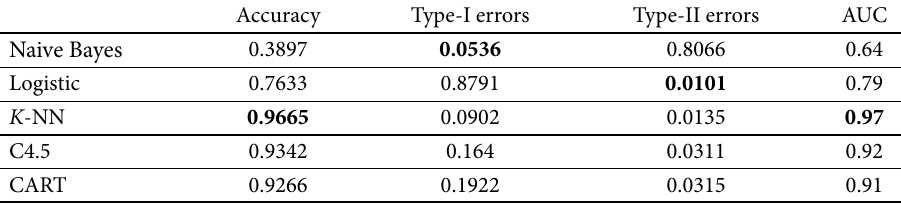
Table 3. Classification results on the ICA test dataset